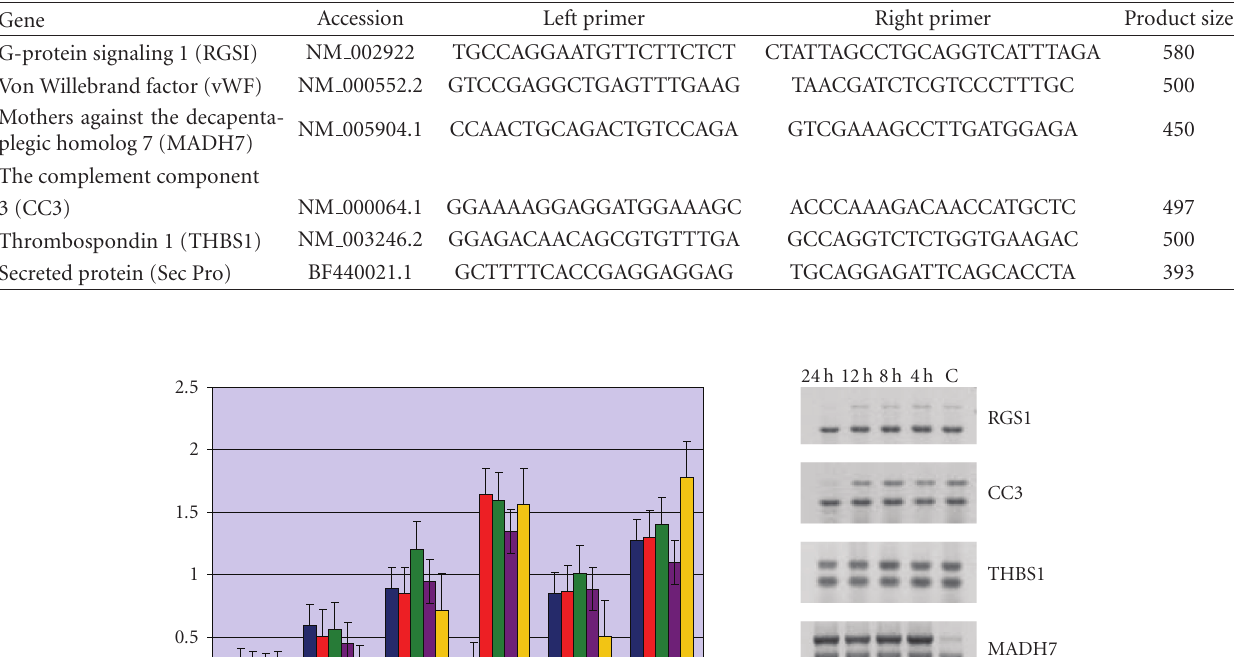
Table 1: RT-PCR primers for various genes.